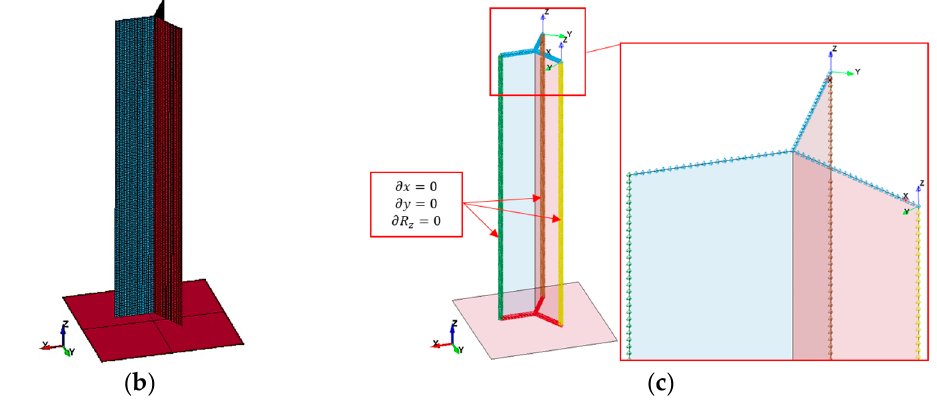
Figure 4. Y element: ( a ) geometric model, ( b ) finite element model, ( c ) boundary conditions.